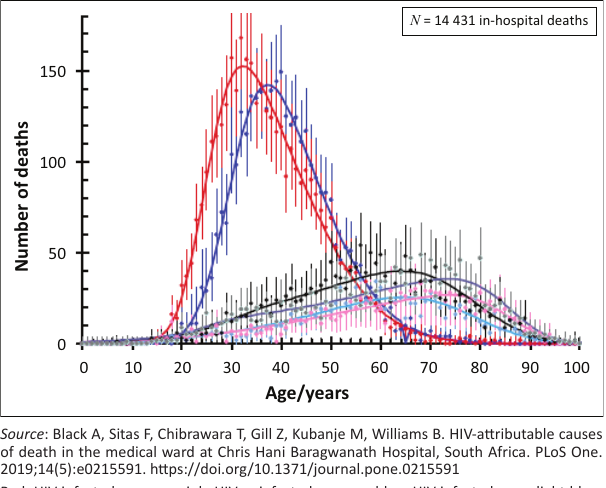
FIGURE 1: The number of deaths by age and HIV-status of men and women admitted to the Chris Hani Baragwanath Hospital, Soweto, 2006–2009.